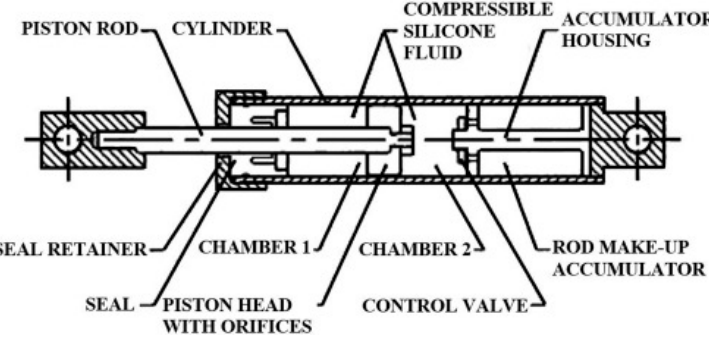
Figure 13. Longitudinal section of a typical Viscous fluid damper.